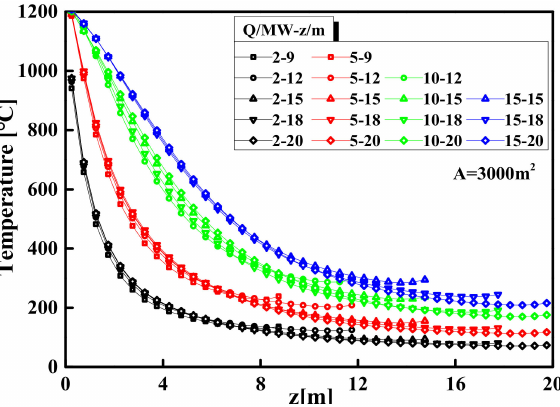
Figure 13. Comparison of plume centerline temperature in different space heights.